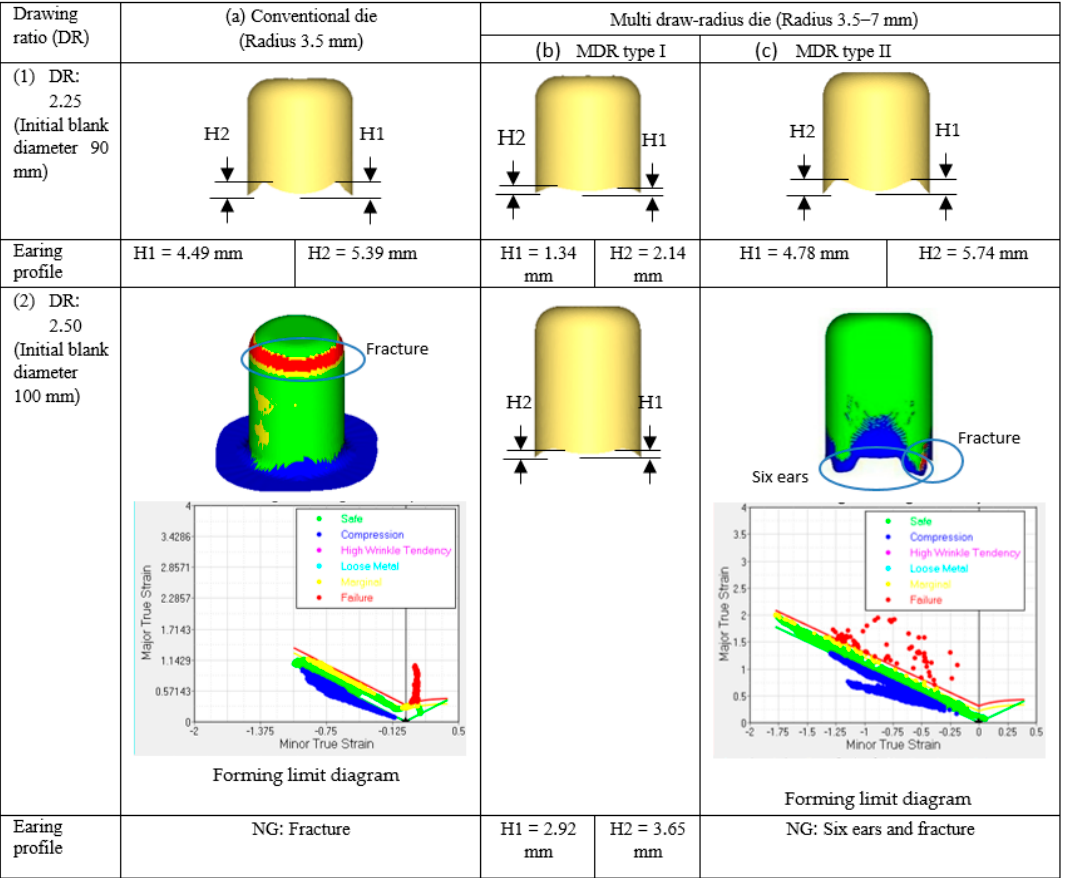
Figure 9. MDR die design related to the anisotropy property of the material: ( a ) Conventional die (Radius 3.5 mm); ( b ) MDR type I; ( c ) MDR type II.